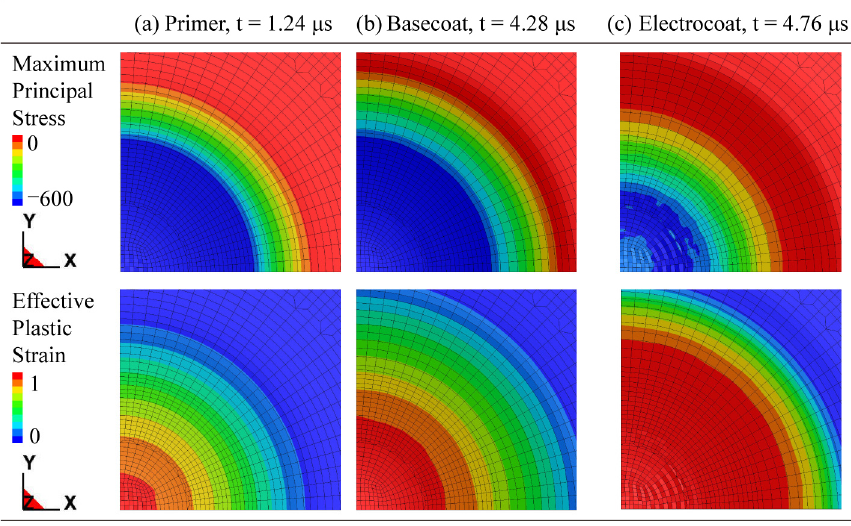
Figure 13. Distributions of maximum principal stress and effective plastic strain of ( a ) primer at 1.24 μ s, ( b ) basecoat at 4.28 μ s, and ( c ) electrocoat at 4.76 μ s in the vicinity of the impact location.